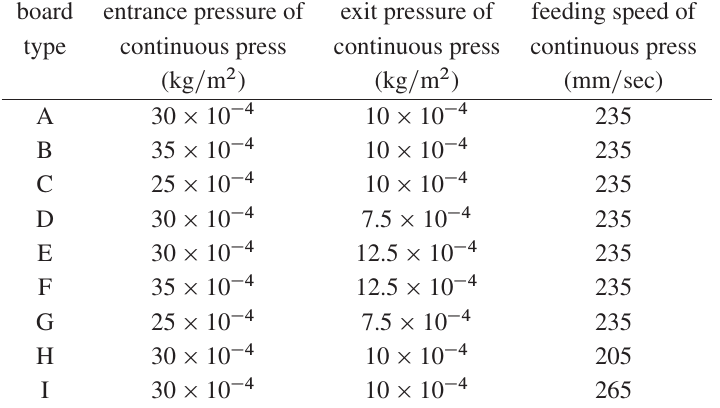
Table 1. The experimental design and panel characteristics.